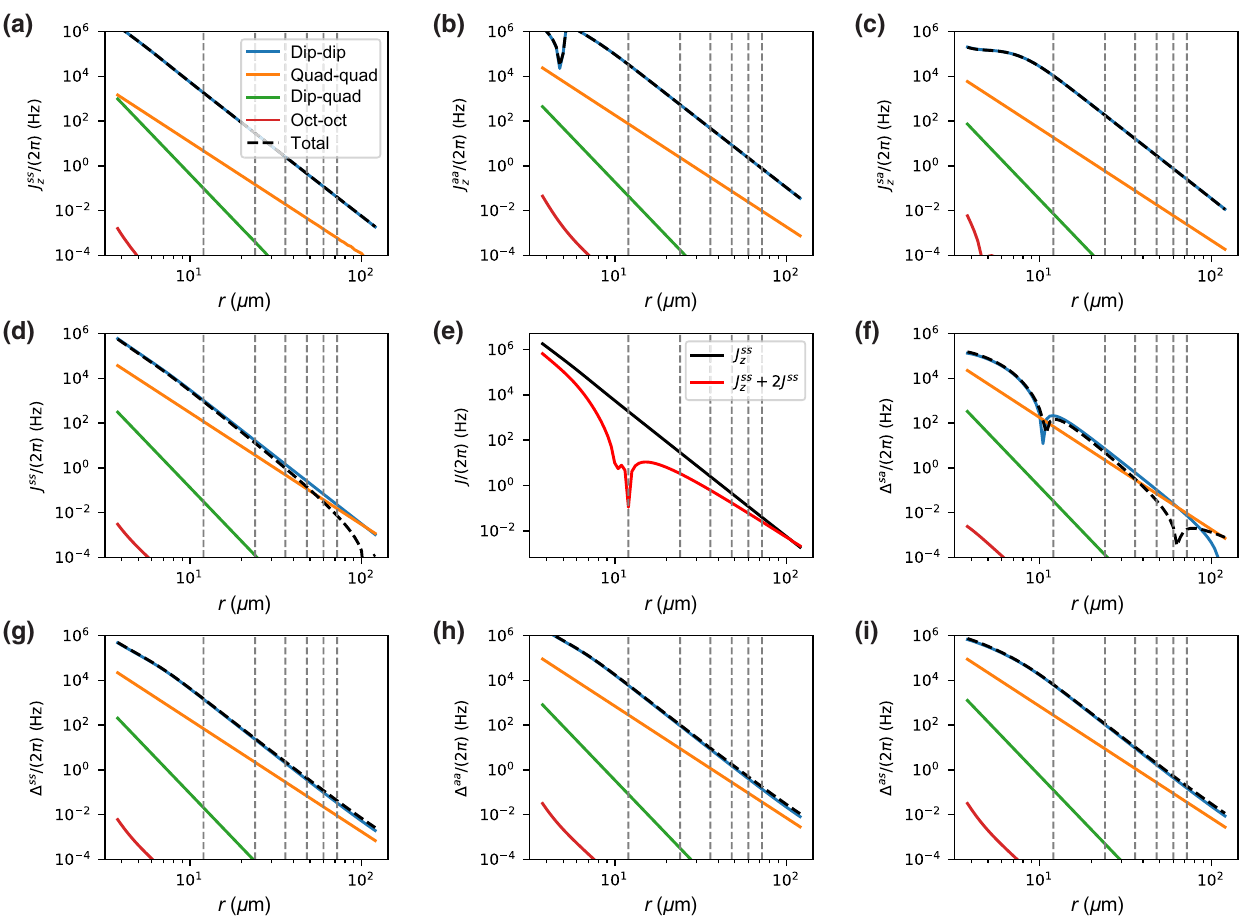
FIG. 11. (a),(d),(g) Magnitude of the interaction coefficients vs distance for the storage states [Eq. (6)]. The vertical lines show the site separation in a 1D lattice with a c = 12 μ m. The colors show the separate contributions from different terms in the multipole + 2 J ss as a function of distance. The B and E fields are tuned to null this quantity precisely for the nearest-neighbor expansion. (e) J ss z site, but the quadrupole contribution to J ss results in imperfect cancellation at more distant sites. (b),(h) Interaction coefficients for the active states [Eq. (8)]. (c),(f),(i) Interaction coefficients between the storage and active states [Eq. (7)].